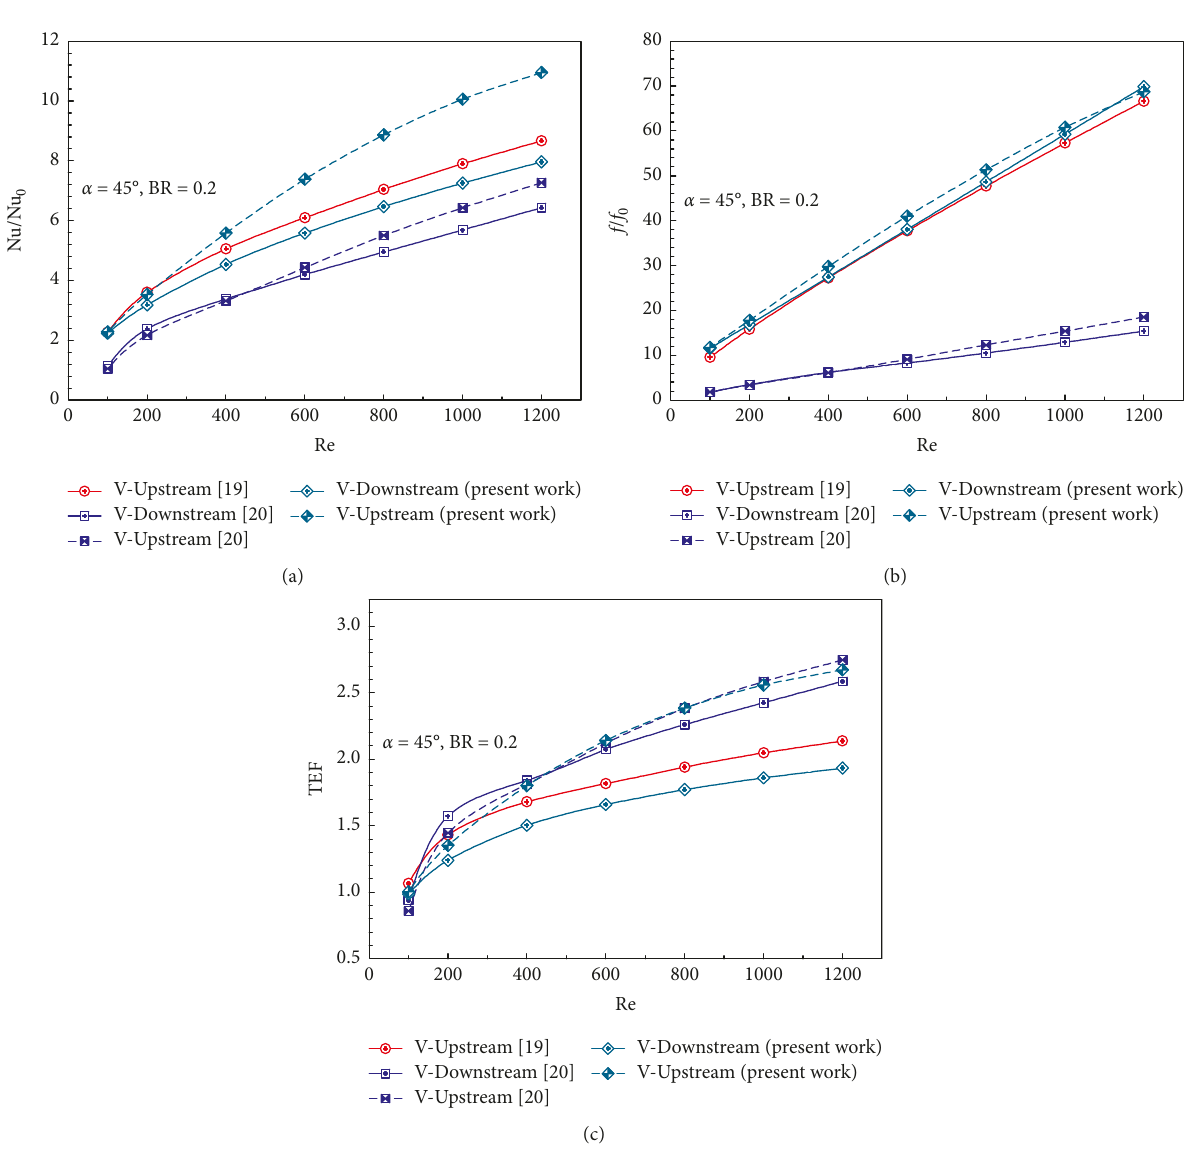
0 vs Re, (b) f / f 0 vs Re, and (c) TEF vs